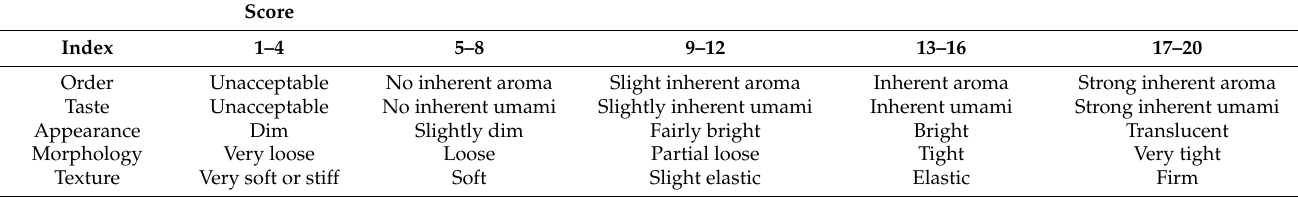
Table 1. Sensory evaluation criteria of swimming crab during